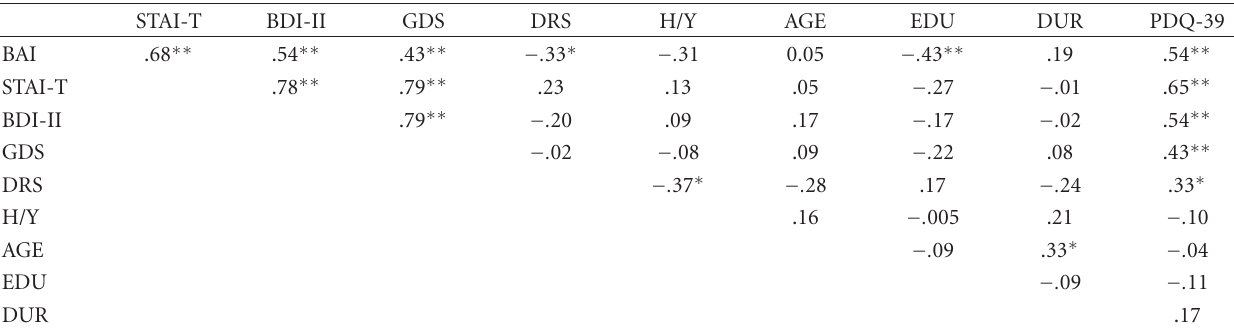
Table 3: Spearman correlation matrix for variables previously demonstrated to a ff ect health-related quality of life in PD.